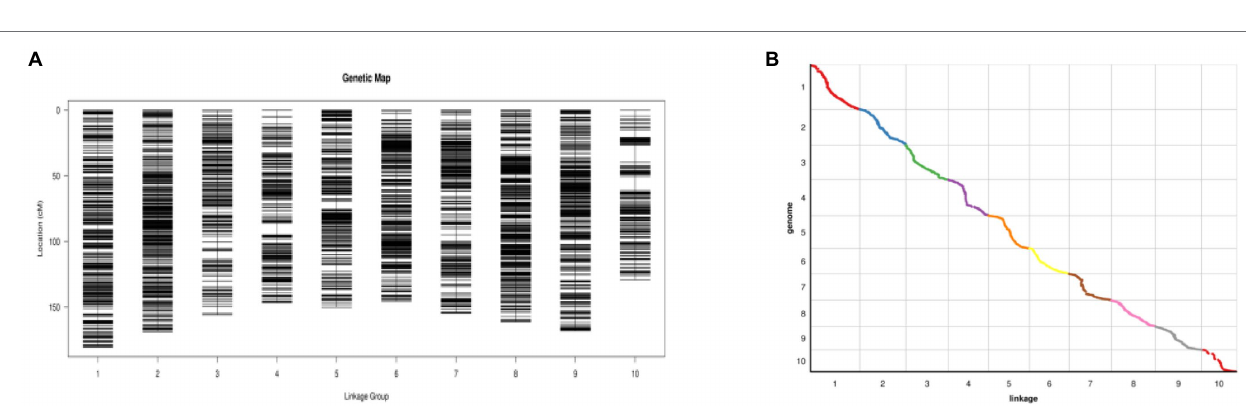
FIGURE 5 | (A) High-density genetic map of the RIL population using SNP markers. The markers are indicated by black bars. The x-axis represents 10 linkage groups, and the y-axis represents genetic distance (Fei et al., 2022). (B) Genetic map and genome collinearity map. Both the x- and y-axes represent linkage groups (Fei et al.,